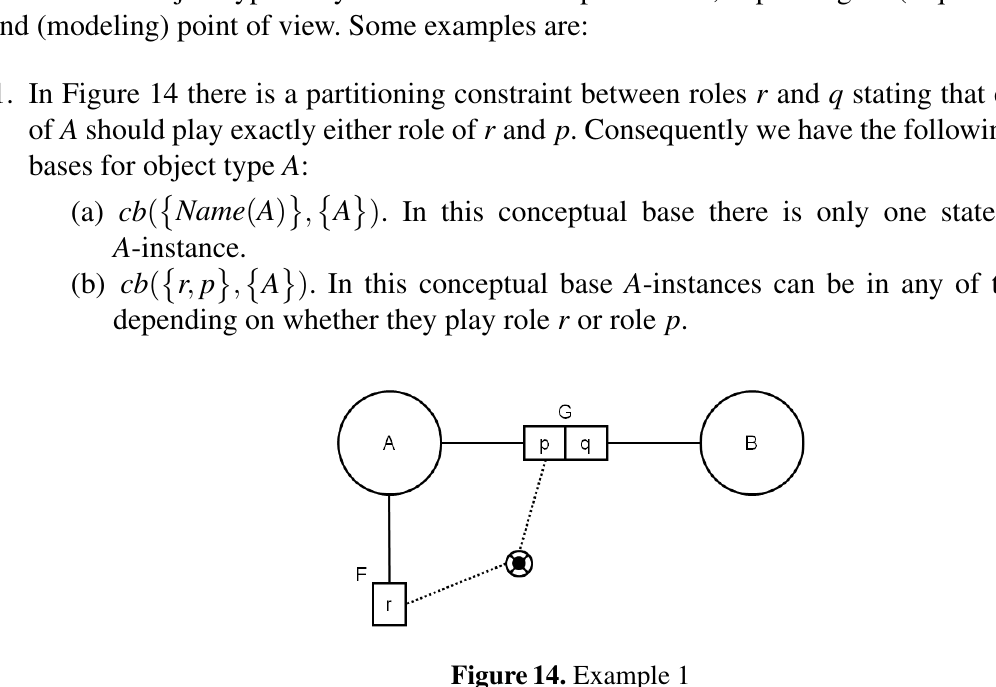
Figure 14. Example 1